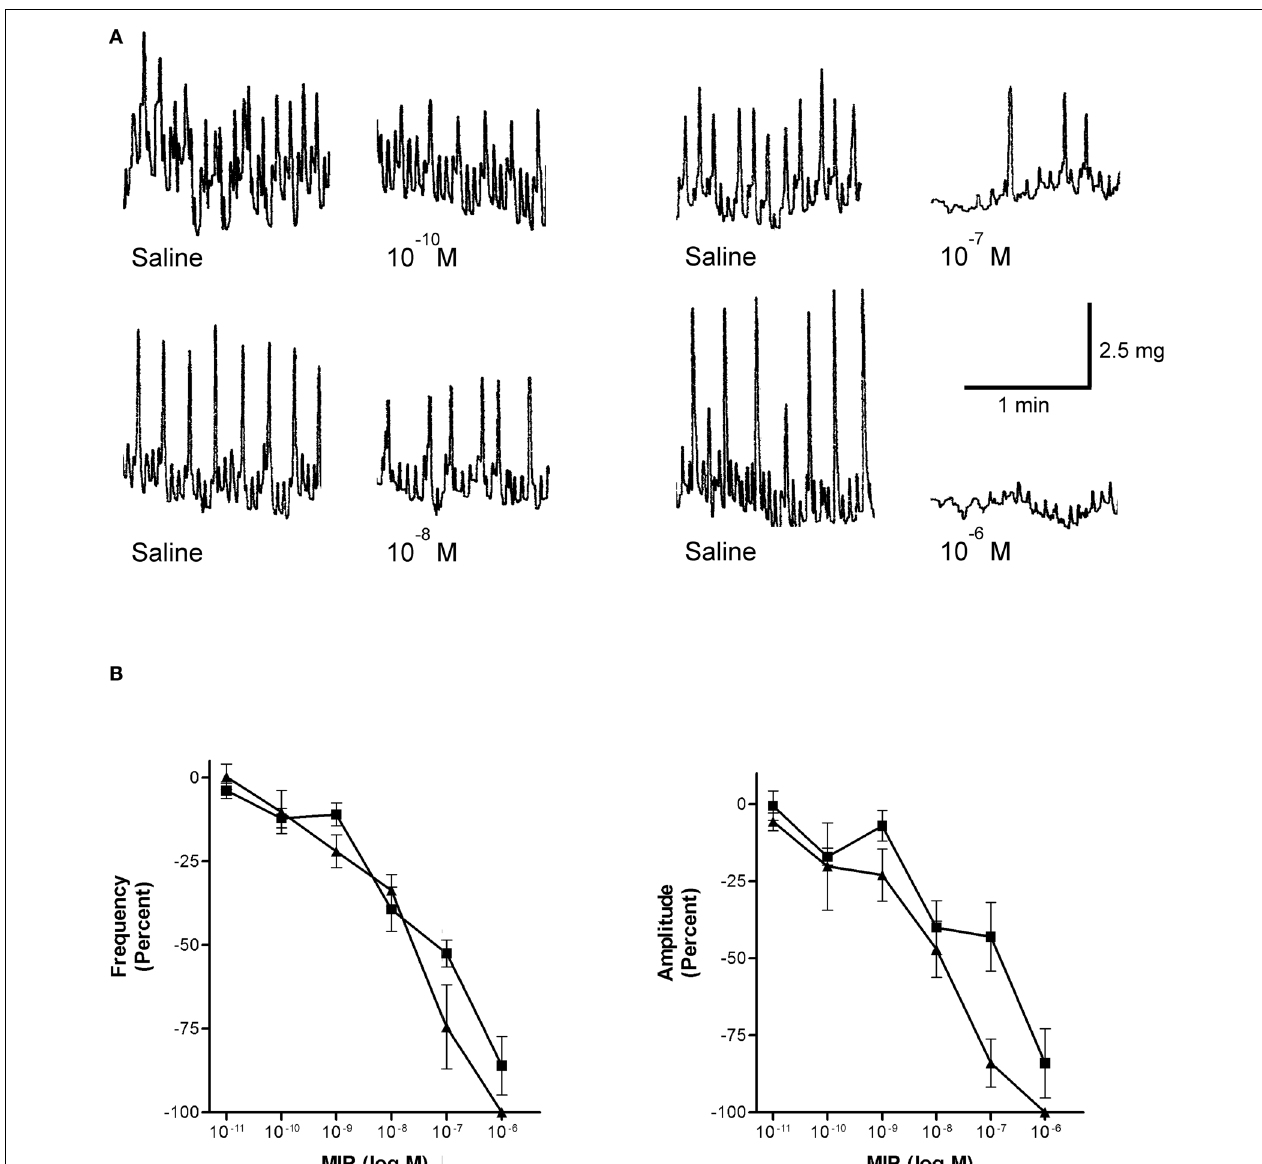
the addition. (B) Rhopr-MIP-4 [W(X 7 )Wamide; triangles] and Rhopr-MIP-7 [W(X 6 )Wamide; squares] inhibit the frequency and amplitude of spontaneous hindgut contractions of R. prolixus in a dose-dependent manner. Symbols are mean ± SE of five to six